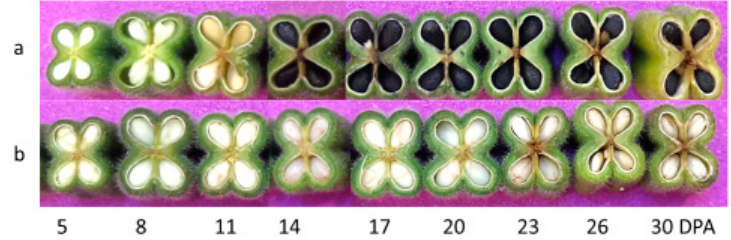
Figure 2. Phenotypes of the seeds at different stages of seed development. ( a ) The black sesame. ( b ) The white sesame.